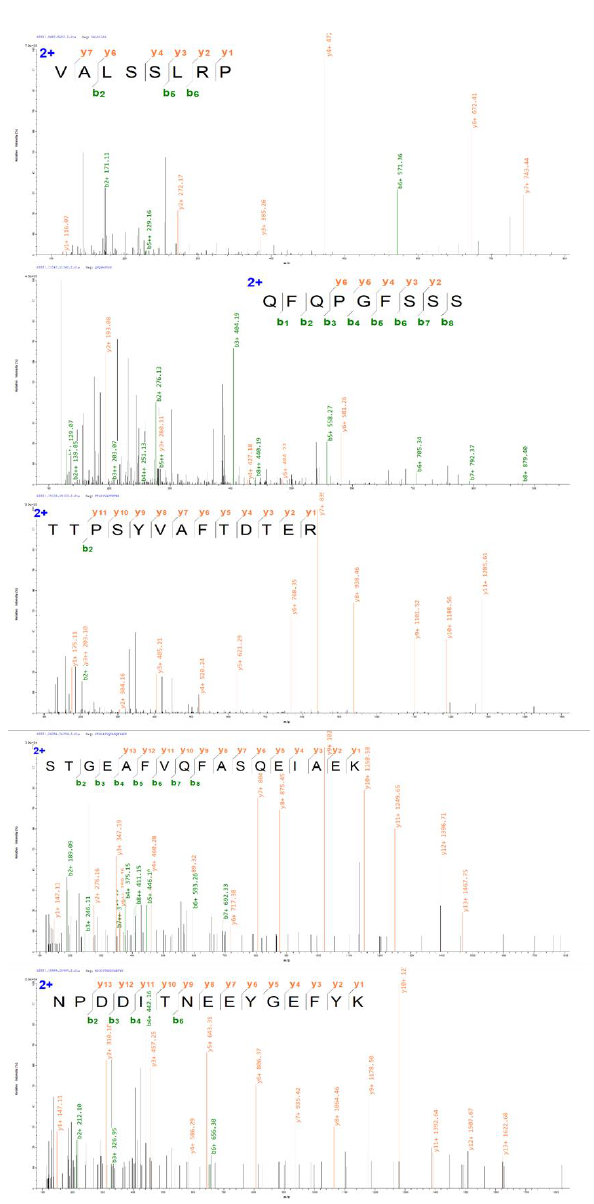
Figure 2. MS/MS spectrums of five ACE – IPs in fraction